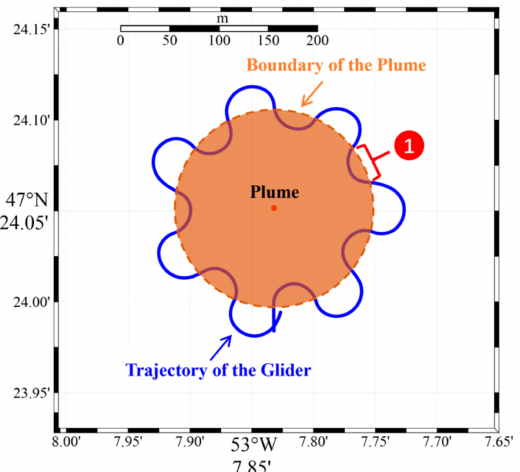
Figure 19. Trajectory of the glider in the horizontal plane under the backseat control of a heading controller, which changed the heading along the boundary of a simulated plume.